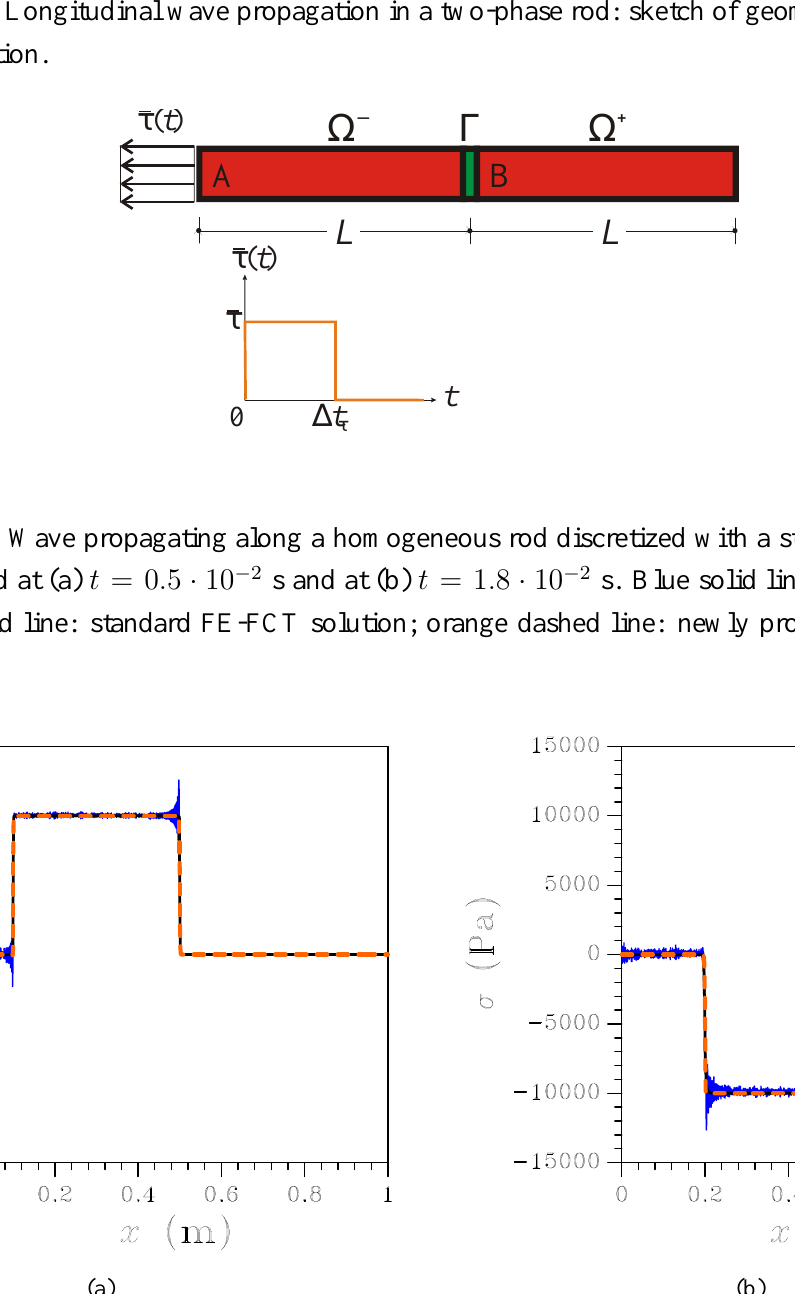
Figure 3. Since in Equations (25)-(32) the ( j − 2) − th, ( j − 1) − th, ( j + 1) − th and ( j + 2) − th terms are dropped when the relevant points (or nodes in the standard formulation) fall outside Ω , the algorithm is enhanced by adopting the same criterion if grid points fall outside the phase the j − th node belongs to. If this procedure is not followed, the FCT correction step can not feel interfaces endowed with their own constitutive